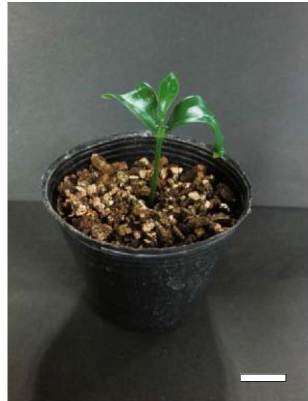
Figure 8. The triploid seedling obtained from the cross between the diploid and the chimera of the Meiwa kumquat (bar = 1 cm).